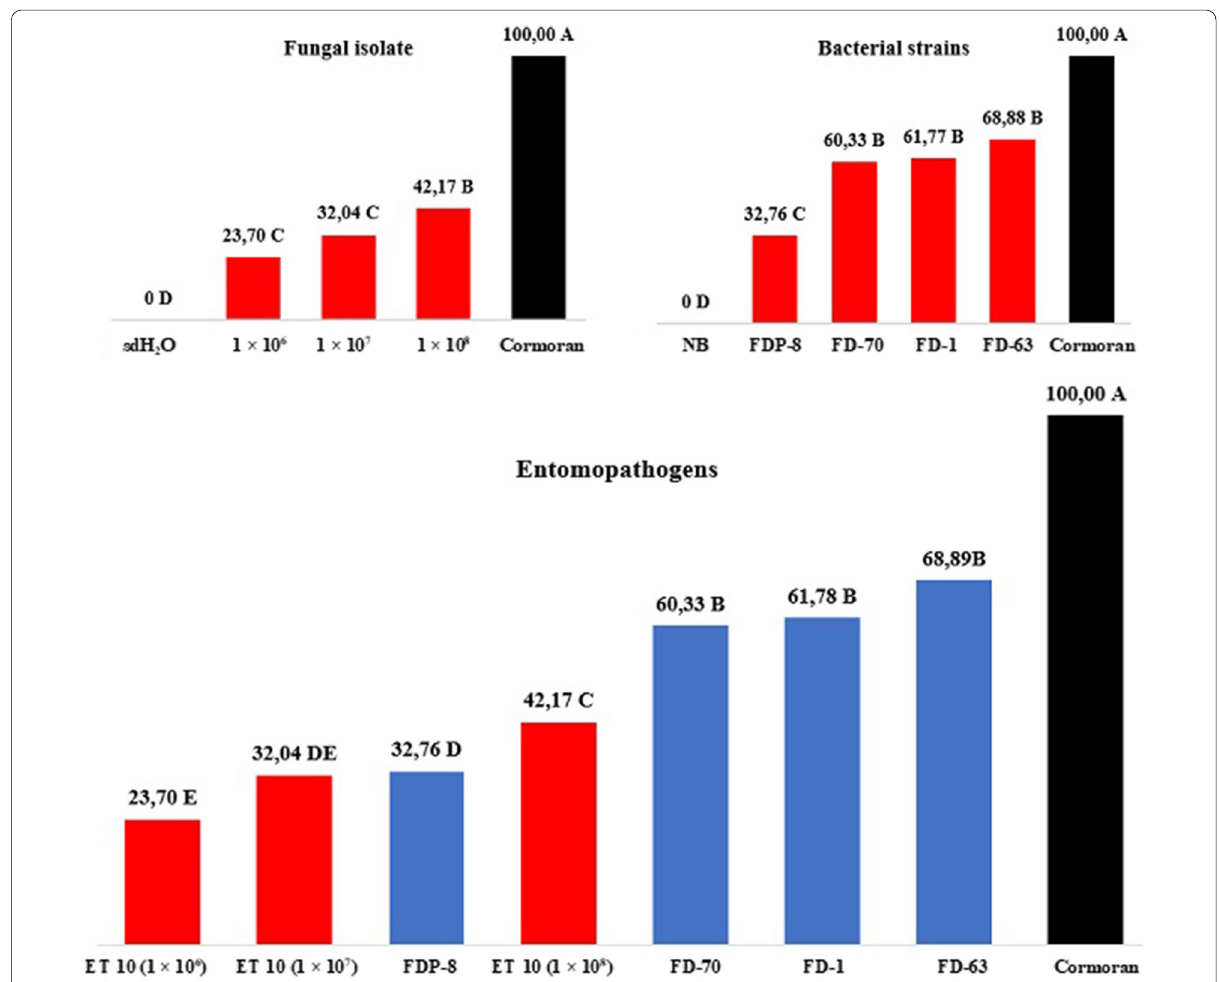
Fig. 1 Comparison of the pathogenic effect of entomopathogens on Cydalima